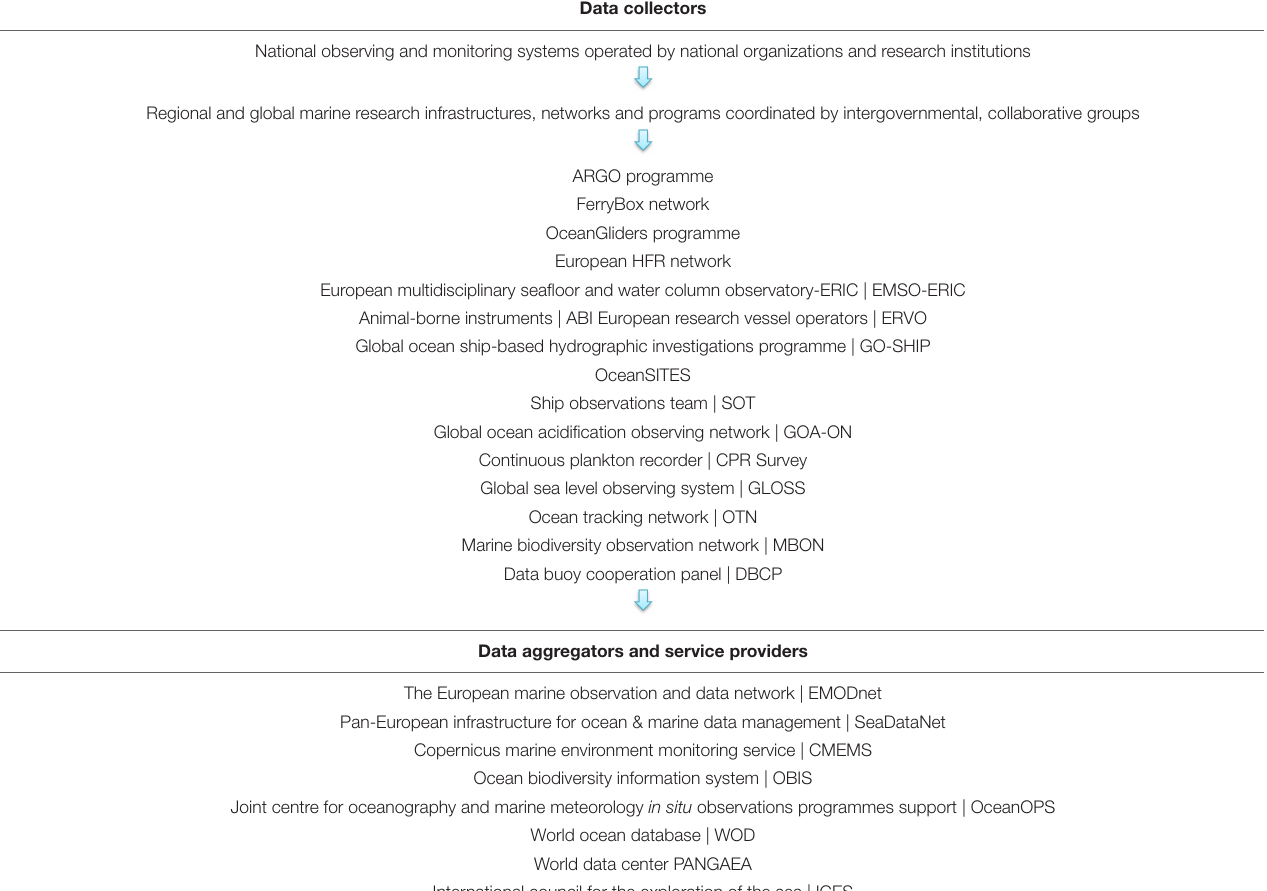
TABLE 1 | List of selected data collectors, data aggregators and service providers in the ocean observation framework at the European